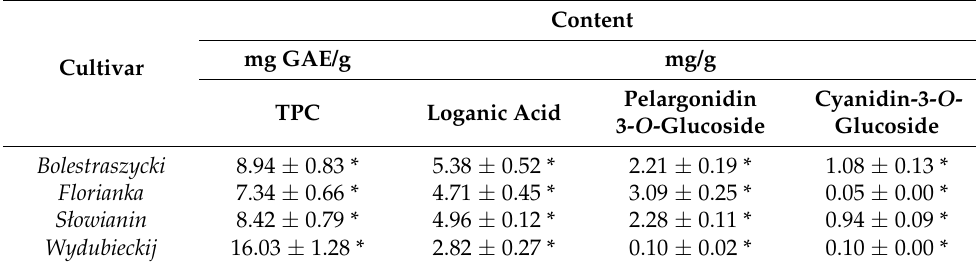
Table 1. The content of active compounds in the lyophilized Cornus mas fruit. Content mg GAE/g mg/g Cultivar Pelargonidin